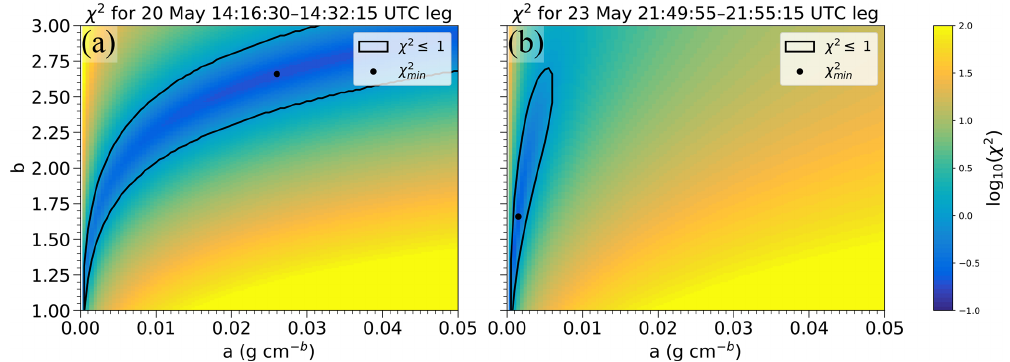
Figure 16. Same as in Fig. 13, but for (a) 14:16:30–14:32:15UTC on 20 May and (b) 21:49:55–21:55:15UTC on 23 May 2011. Outlined regions represent χ 2 ≤ 1, and the dots represent χ 2 min